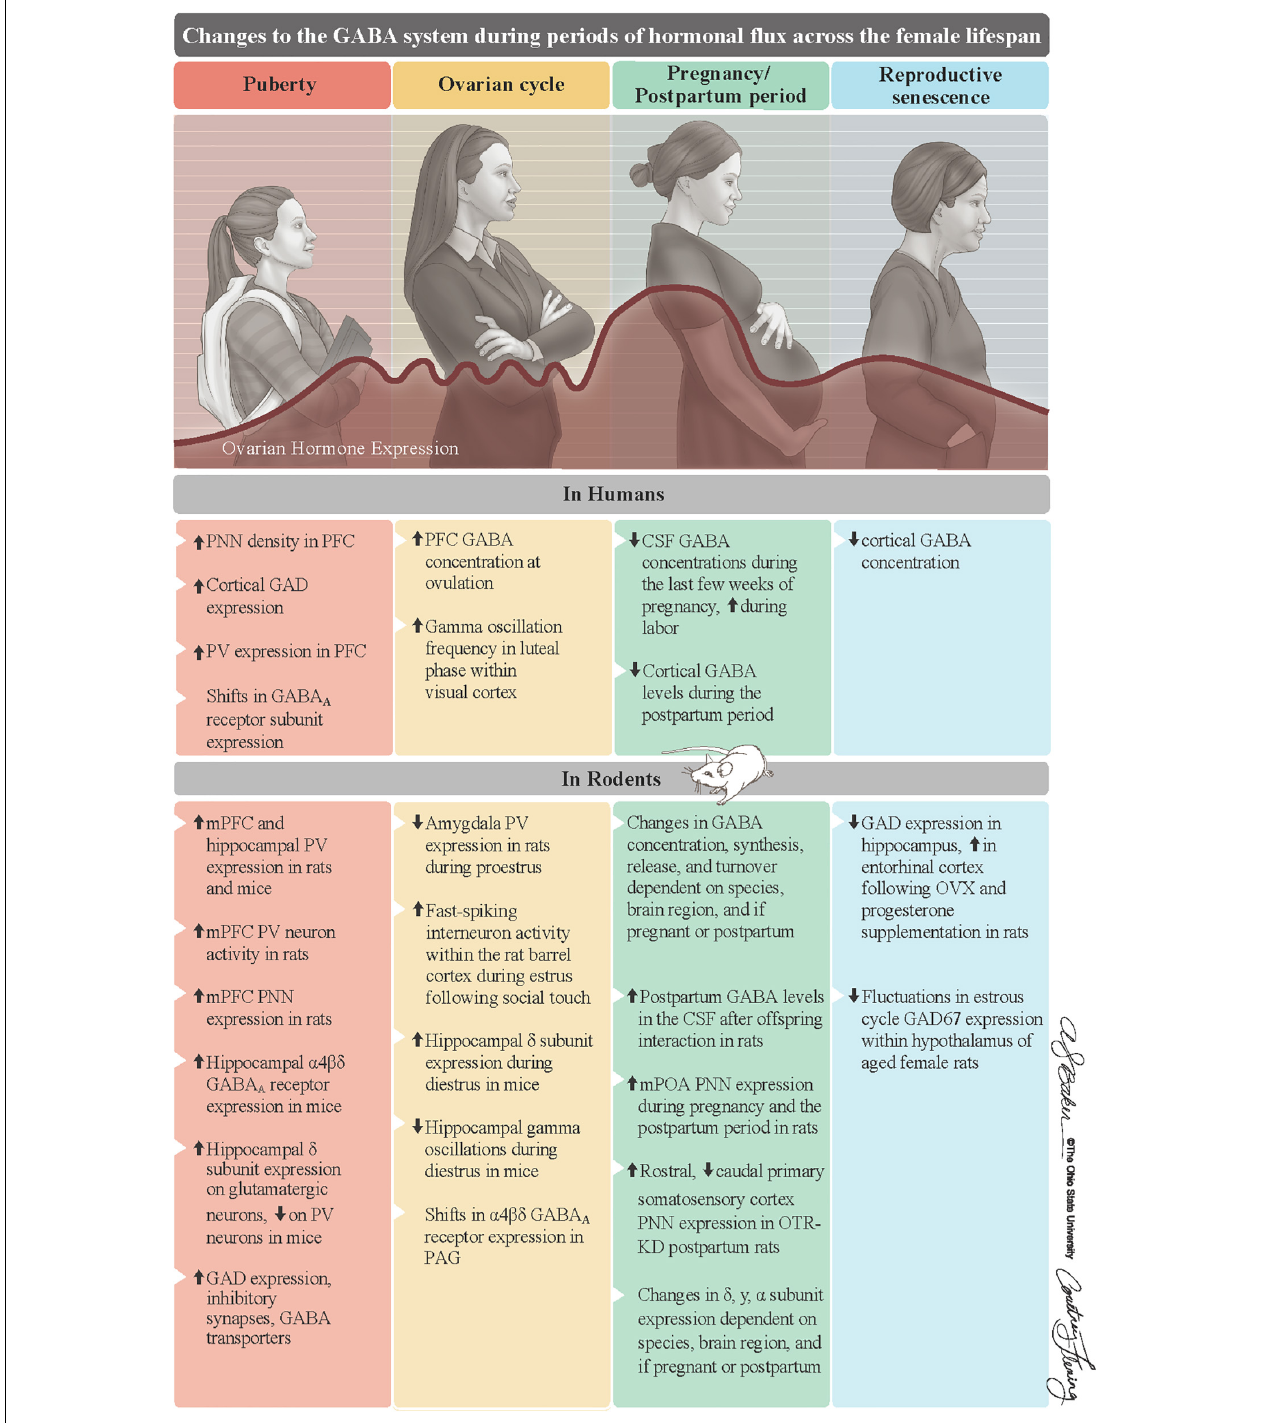
FIGURE 2 | Summary of changes to the GABA system of females during periods of hormonal flux. Ovarian hormones substantially change across the female lifespan. They first increase at puberty, fluctuate on an infradian cycle during reproductive years, surge to their lifelong peak during pregnancy, and steadily decline into reproductive senescence. Along with ALLO, these fluctuations in ovarian hormones, which are mostly recapitulated in rodents, are associated with changes to GABA system in both humans (top row) and rodents (bottom row). Reproduced with the permission of The Ohio State University, patterned after Figure 1 in Barrientos et al. (2019). ALLO = allopregnanolone, CSF = cerebrospinal fluid, GAD = glutamate decarboxylase, OTR-KD = oxytocin receptor knockdown, mPFC = medial prefrontal cortex, mPOA = medial preoptic area, PAG = periaqueductal gray, PNNs = perineuronal nets, PV = parvalbumin.